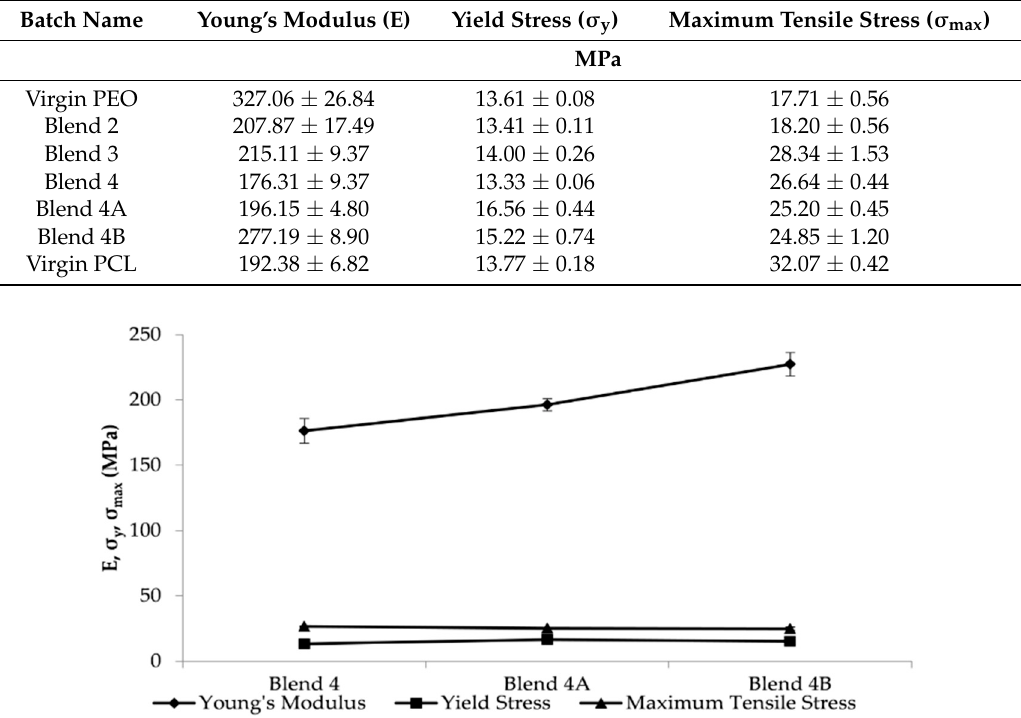
Table 5. Mechanical testing results of prepared batches.